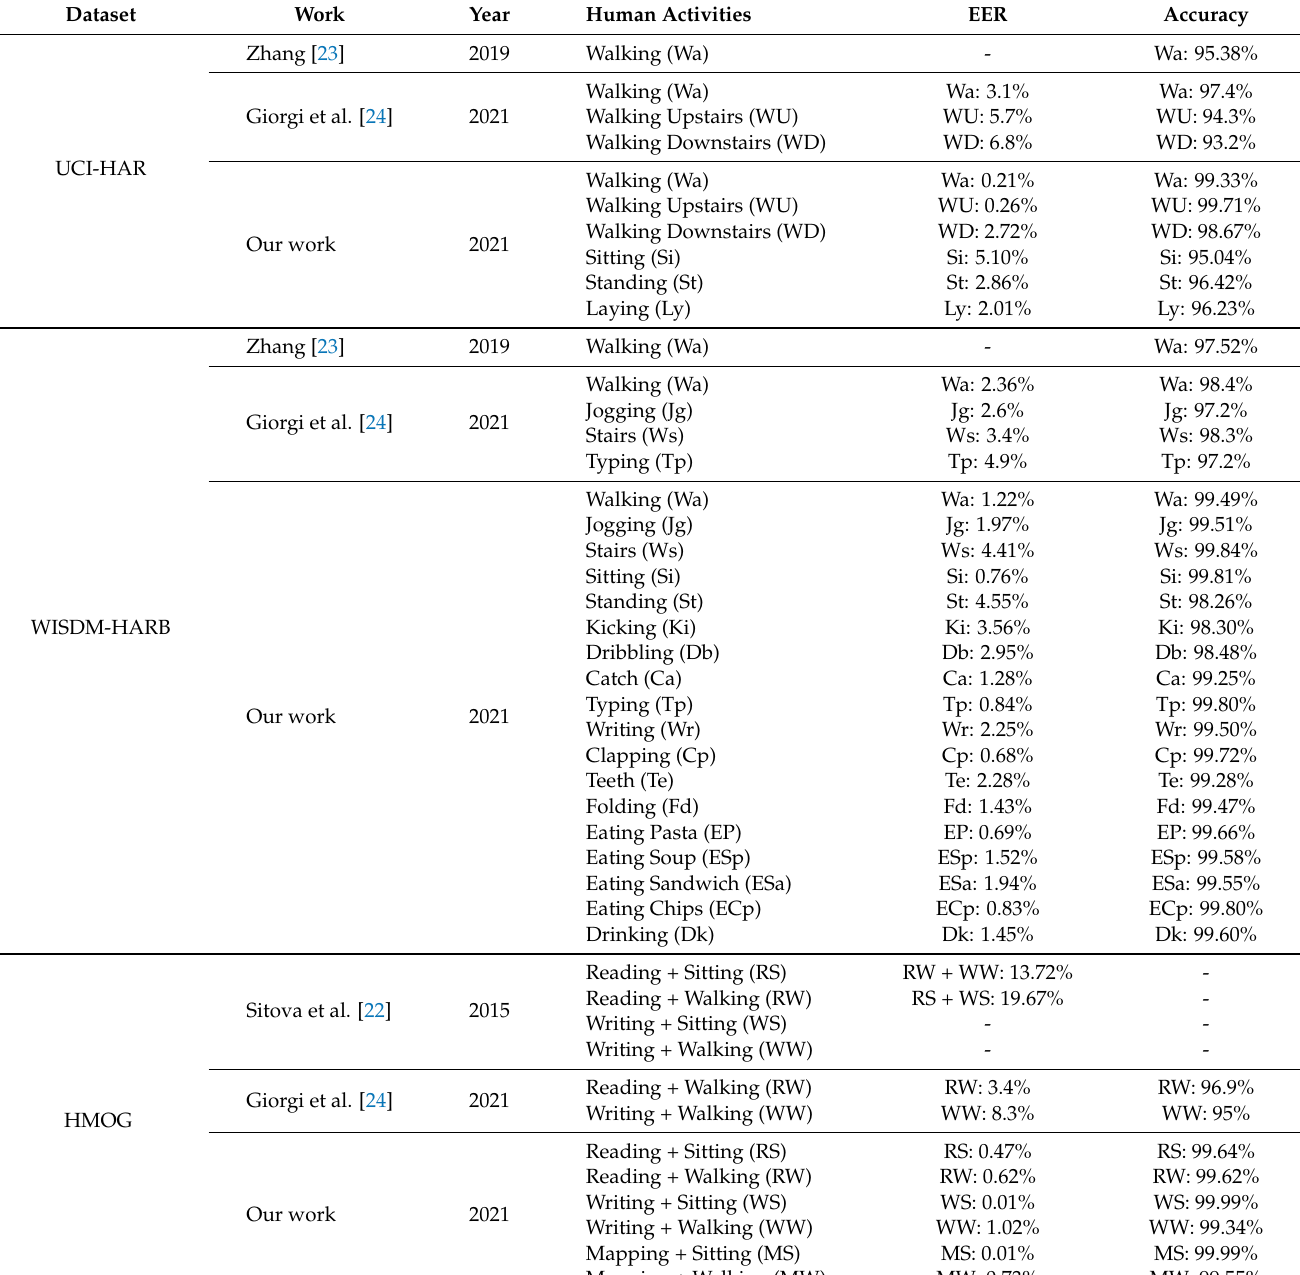
Table 1. Comparison table of our study and the related literature in term of accuracy, EER, and human activities considered.